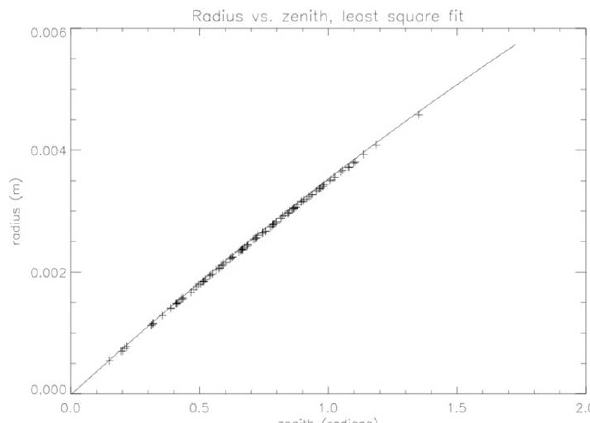
Fig. 3. The least square fit (solid line) on the plot of radius (from the optical axis on the CCD) versus zenith angle (obtained from sky map).